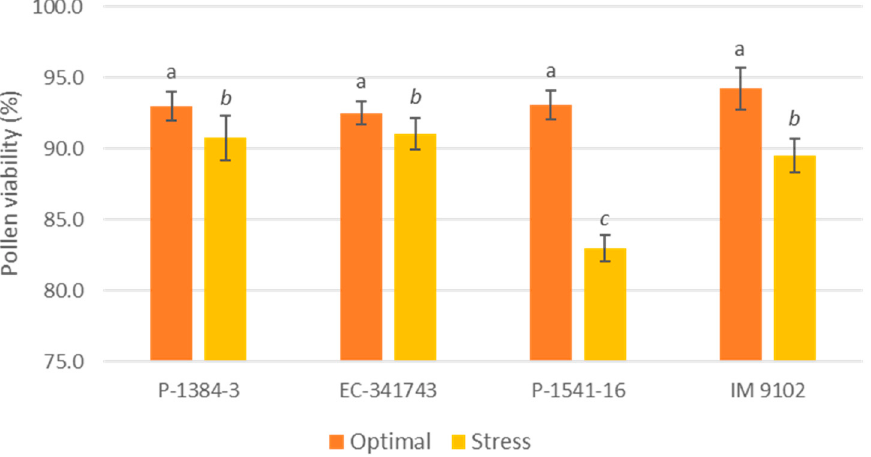
Figure 5. Pollen viability of four field pea genotypes under optimal and heat stress. Columns with different letters indicate significant difference at p ≤ 0.05 (Fisher LSD test).